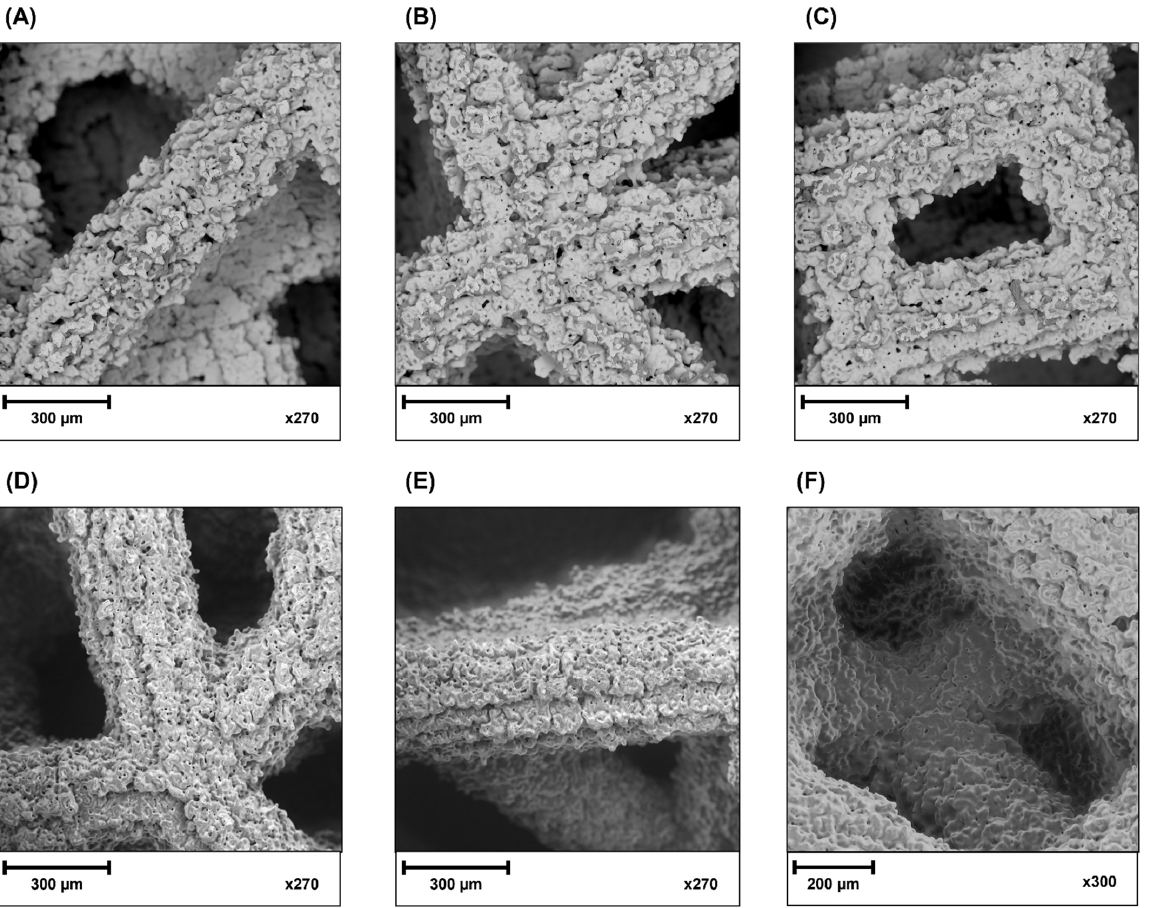
Figure 8. The SEM (PHENOM PRO) images of the Voronoi structure: ( A – C ) before and ( D – F ) after modification with DLC coating. Figure 8F was created as a combination of several SEM images obtained for different levels of the analyzed structure.